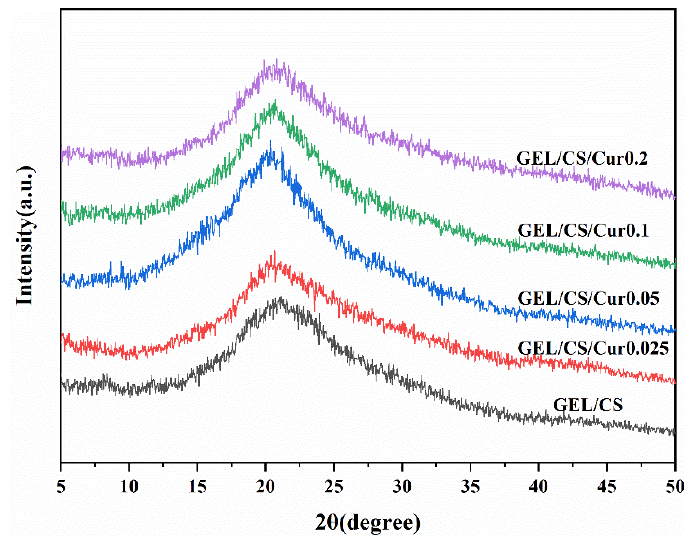
Figure 5. X-ray diffraction patterns of GEL/CS and GEL/CS/Cur composite films.